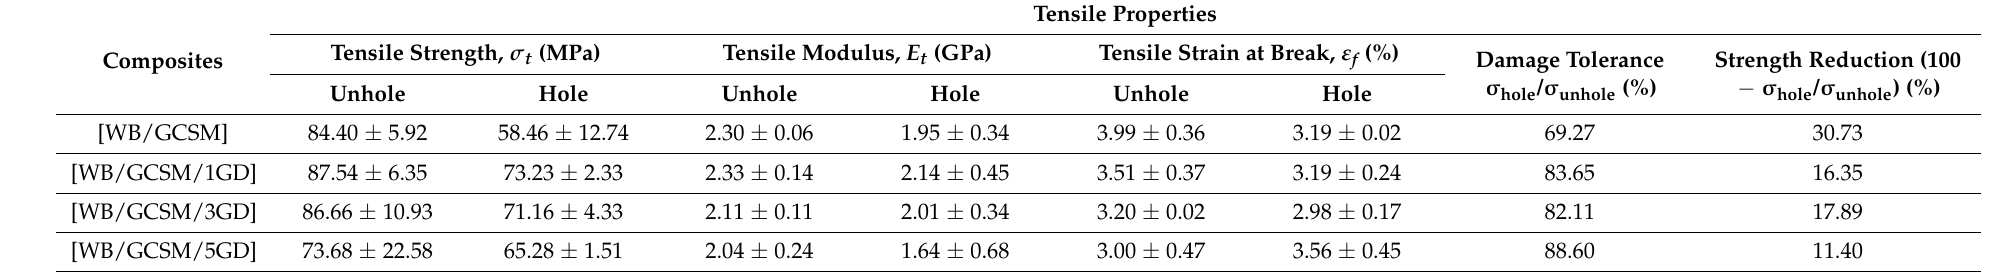
Table 2. Summarised UHT and OHT properties of [WB/GCSM], [WB/GCSM/1GD], [WB/GCSM/3GD] and [WB/GCSM/5GD]